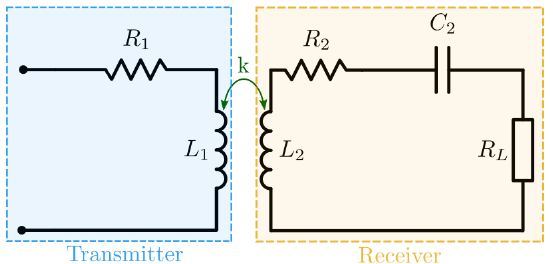
Figure 4. Reference circuit for optimizing the dimensions of the coils.